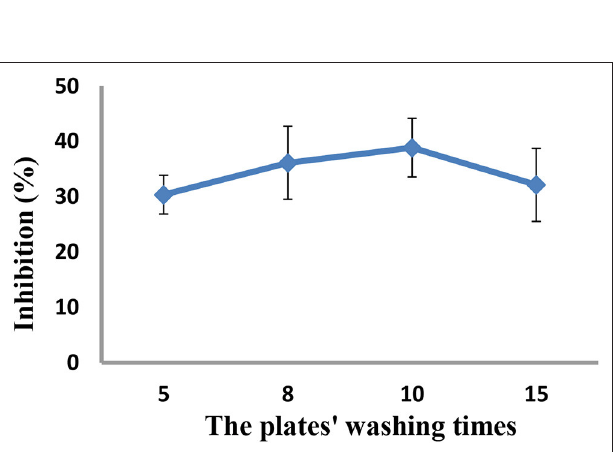
FIGURE 4 | Optimization of the plates’ washing times.